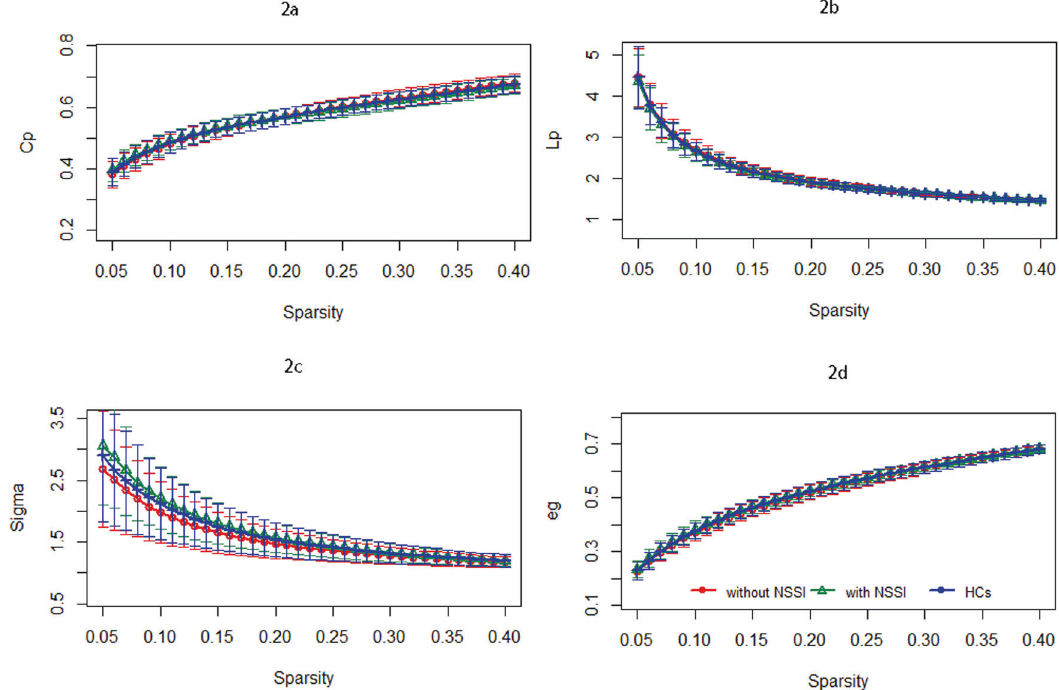
Fig. 2 Comparison of global connectome topology differences between different groups. a – d Comparisons between MDD patients with NSSI and HCs and MDD patients with and without NSSI of Cp, Lp, Sigma and Eg. MDD major depressive disorder, NSSI nonsuicidal self-injury, HCs healthy controls, Cp clustering coef fi cient, Lp path length, Eg global ef fi ciency.